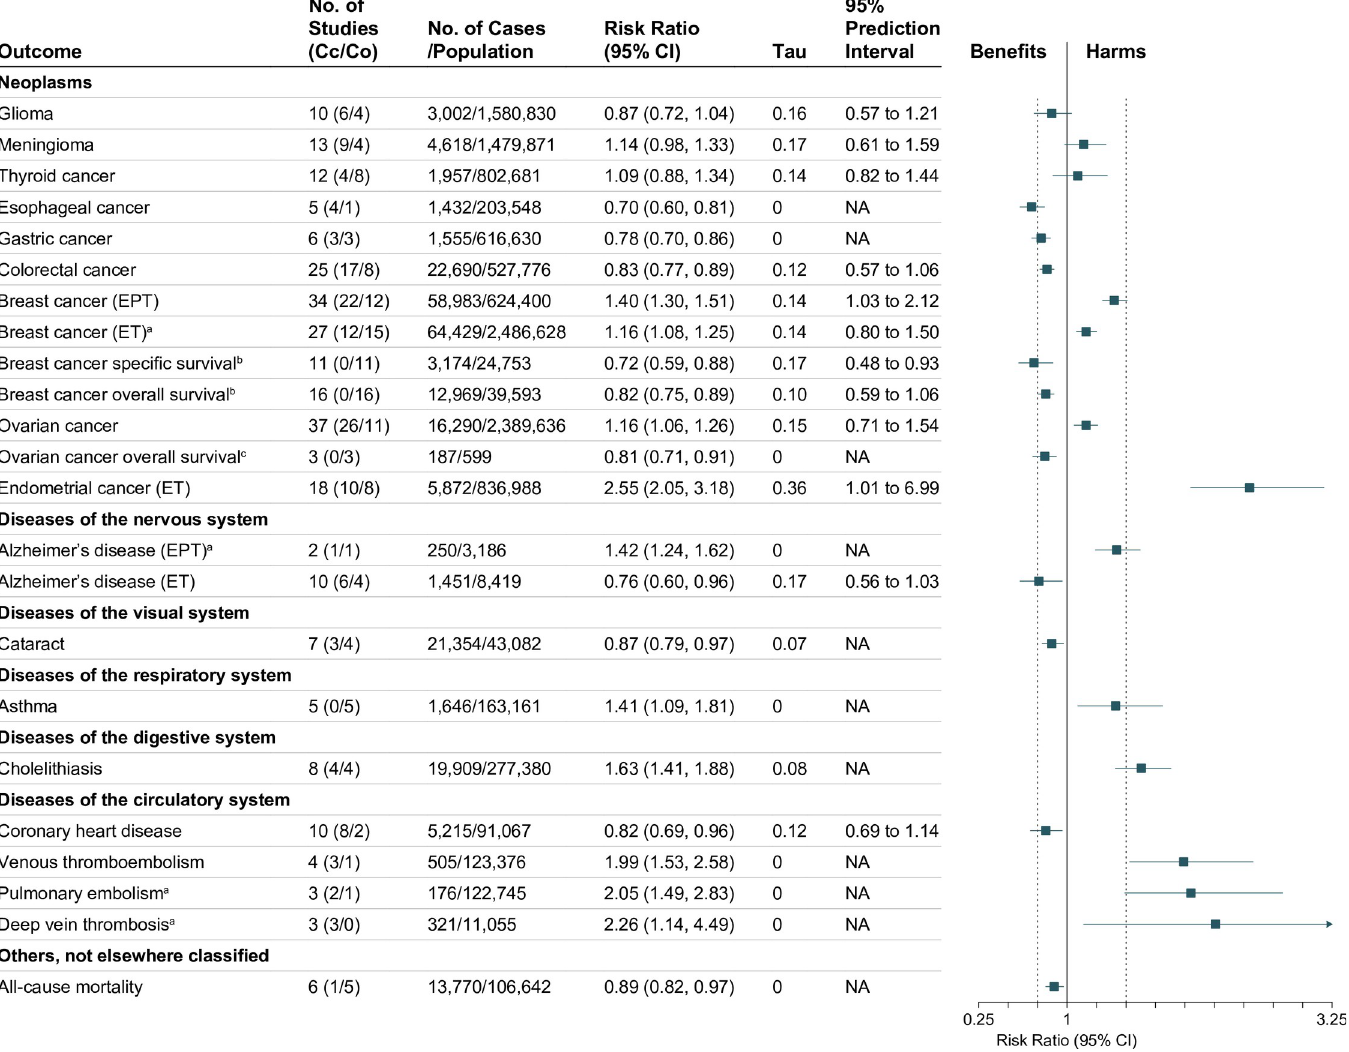
Fig 4. Consistent or highly suggestive evidence from meta-analyses of observational epidemiological studies on menopausal hormone therapy and incidence of diseases and other health outcomes. The average effects of any menopausal hormone therapy (ET or EPT) in perimenopausal or postmenopausal women, unless otherwise stated. The estimates are for ever use of menopausal hormone therapy, unless otherwise stated. All estimates are from our own analysis. Subgroup analysis results by type and recency of menopausal hormone therapy use can be found in Tables L to Q in S1 Text. The center of each square represents the summary average effect for each outcome, and the horizontal line represents the corresponding 95% CI. Cc, case–control study; CI, confidence interval; Co, cohort study; EPT, estrogen plus progestin therapy; ET, estrogen-alone therapy; NA, not available or not applicable. a Current use of menopausal hormone therapy. b Use of menopausal hormone therapy before or after diagnosis of cancer. c Use of menopausal hormone therapy after diagnosis of